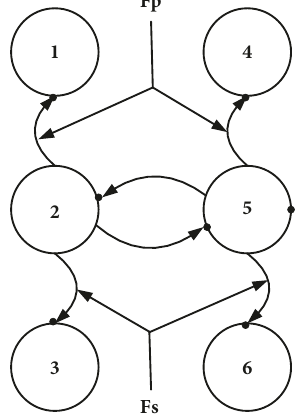
Figure 14: The serial number of CPG neurons.